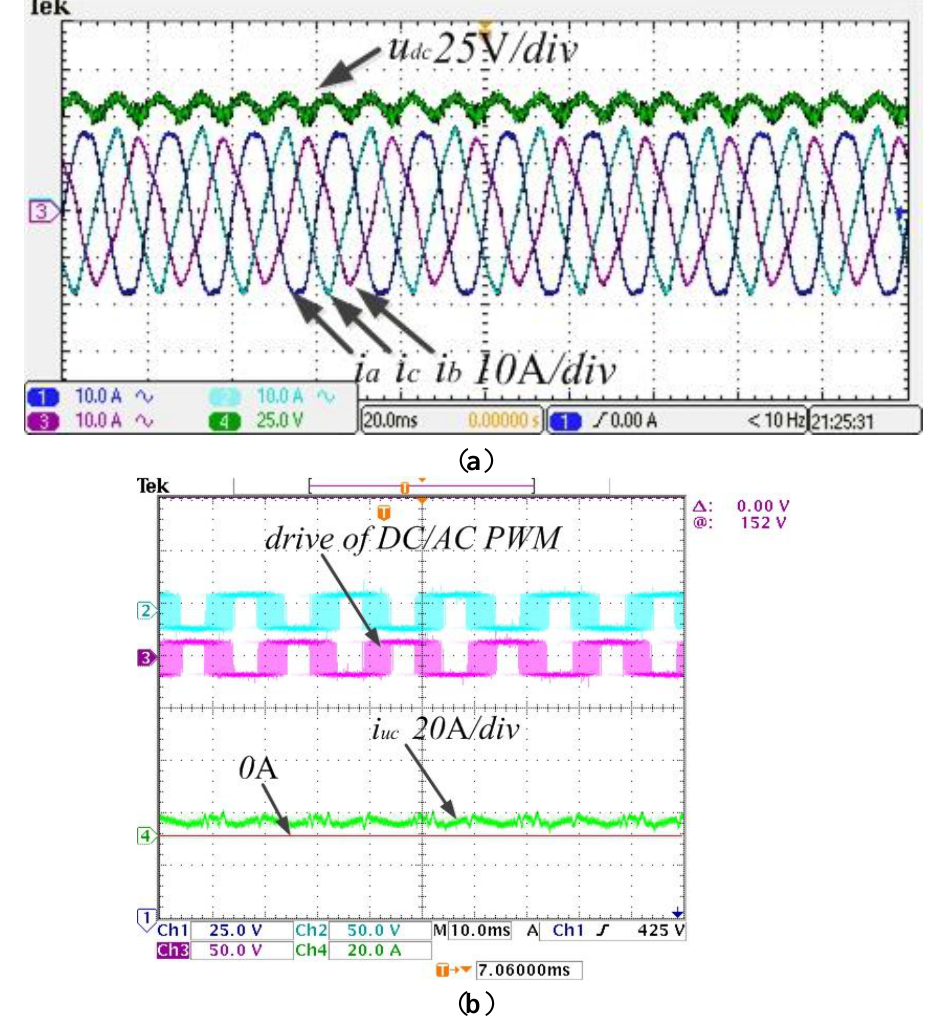
Figure 9. Waves of PI regulator for DC link voltage: ( a ) waves of DC link voltage and unbalanced three-phase current; ( b ) waves of UC current with and PWM driver of GSC.